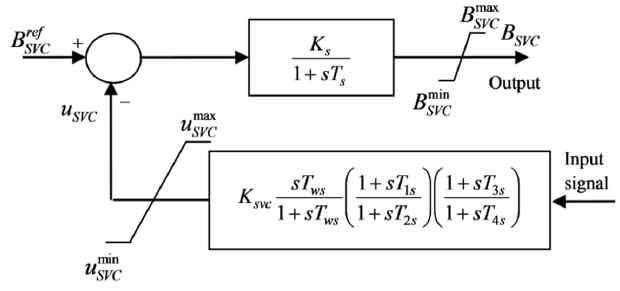
Figure 8. The block diagram of SVC based damping controller.